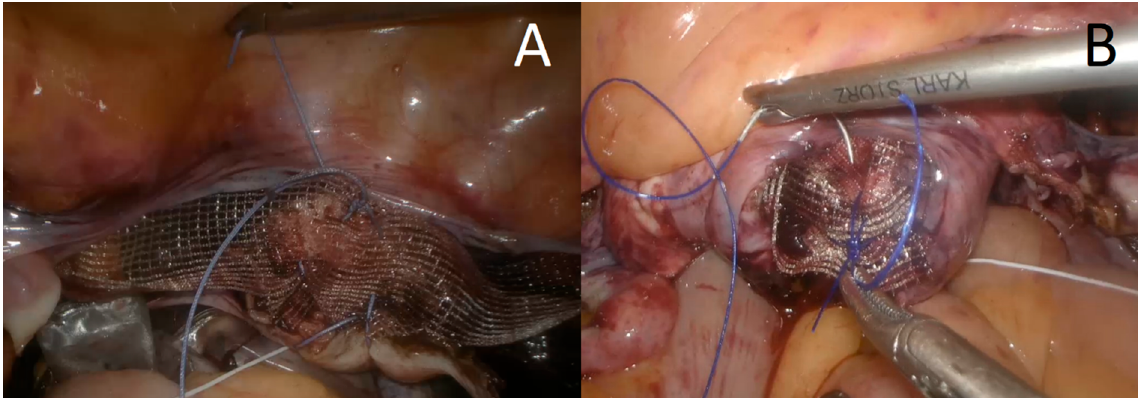
Figure 1. Mesh attachment during laparoscopic pectopexy to the cervix ( A ) or vaginal cuff ( B